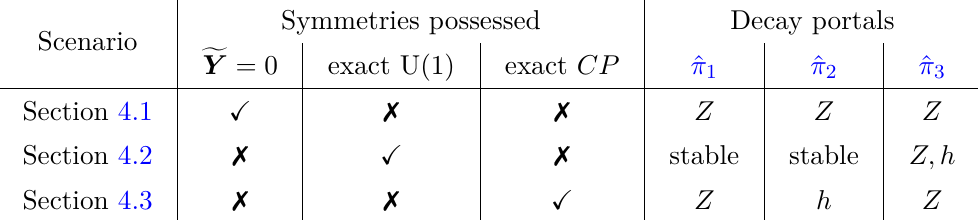
Table 1 . Summary of the benchmark scenarios considered in this work. A chiral symmetry can be the origin of e Y = 0 . In the second scenario, ˆ π particle charged under a dark U(1)